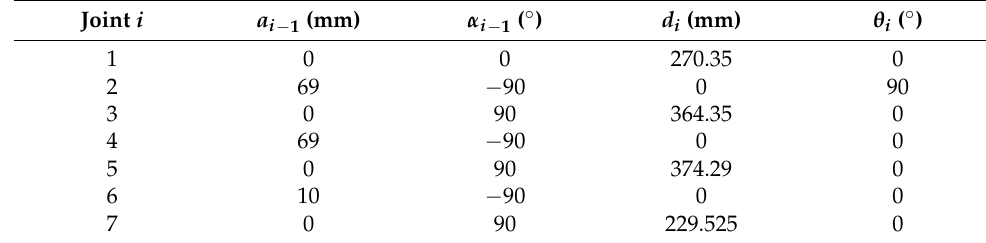
Figure 3. Structure diagram of the redundant robot manipulator. Table 1. DH parameters of the redundant robot manipulator.